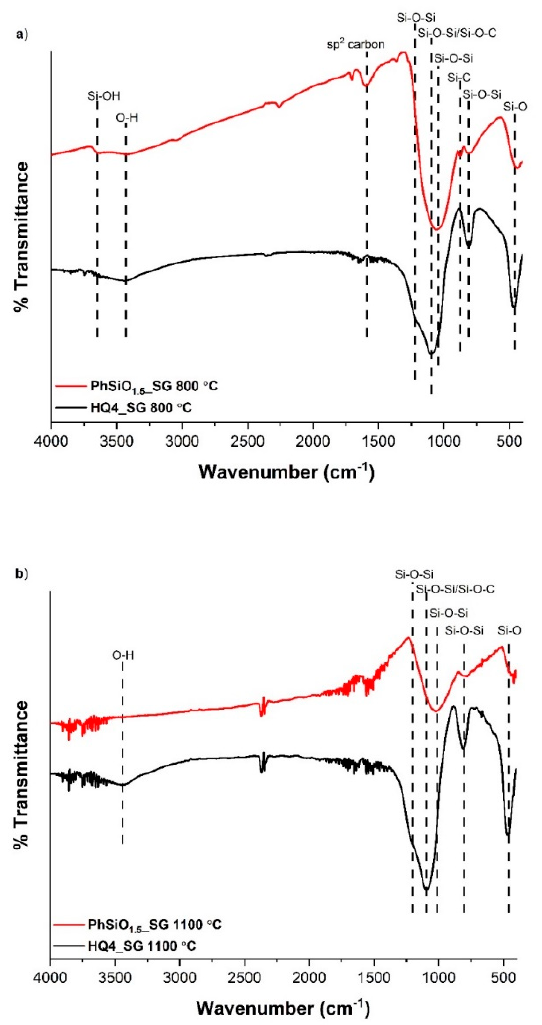
Figure 4. FTIR spectra of HQ4_SG and PhSiO 1.5 SG pyrolyzed to ( a ) 800 °C and ( b ) 1100 °C.